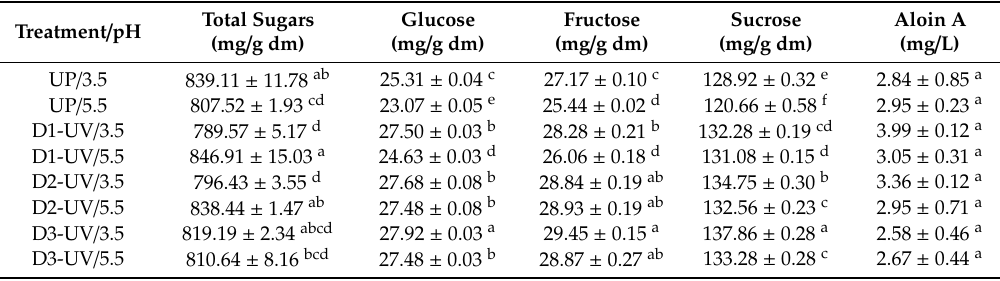
Table 3. Total, simple sugars, and Aloin A content of A. vera –pitaya blend associated with di ff erent pH values and UV-C irradiation